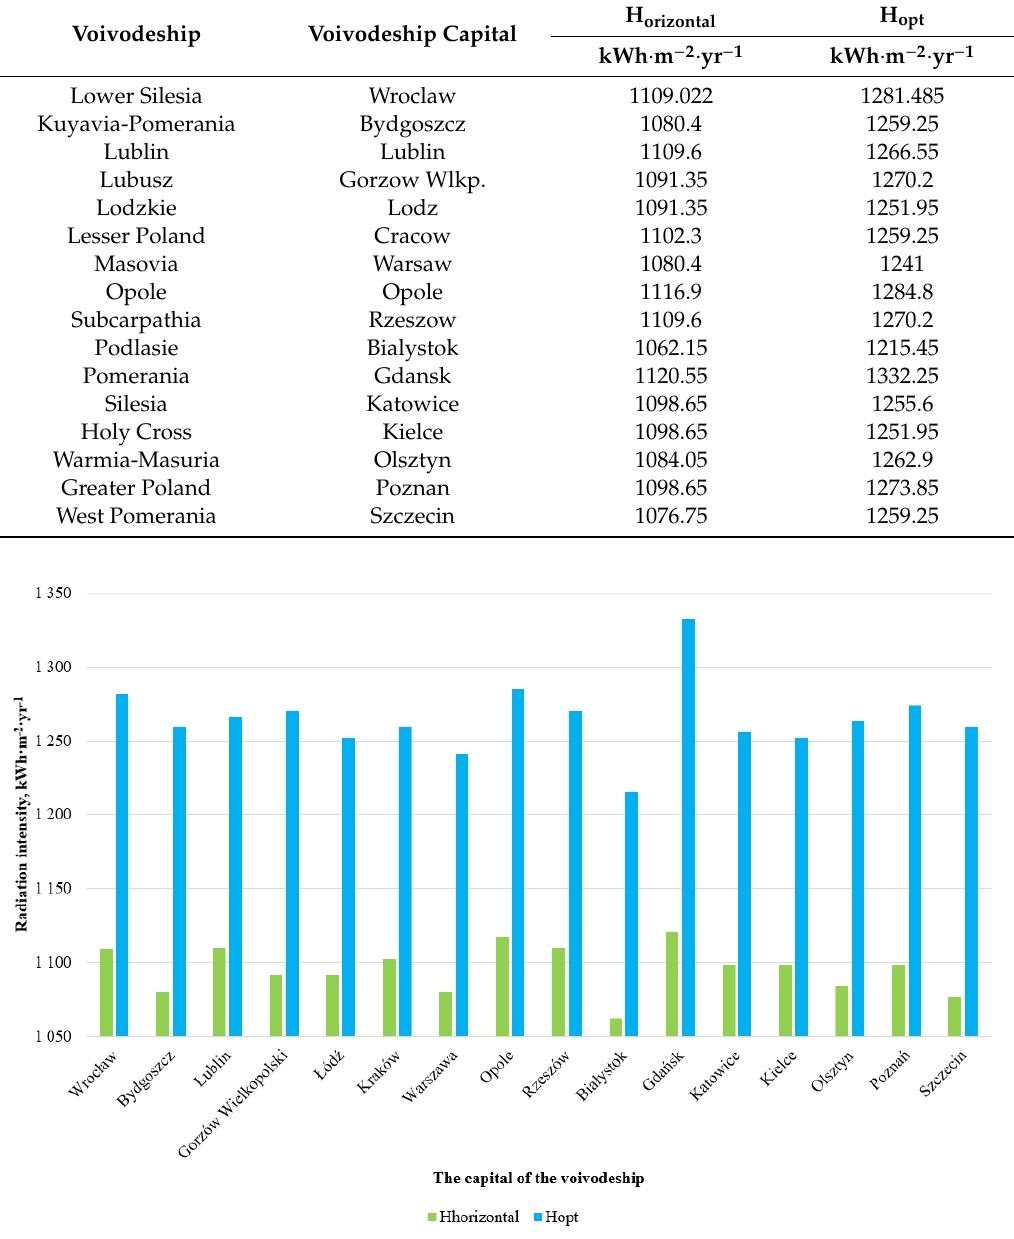
Figure 3. The amount of energy reaching the horizontal surface and surface set at an optimal angle for individual voivodeship capital [47].